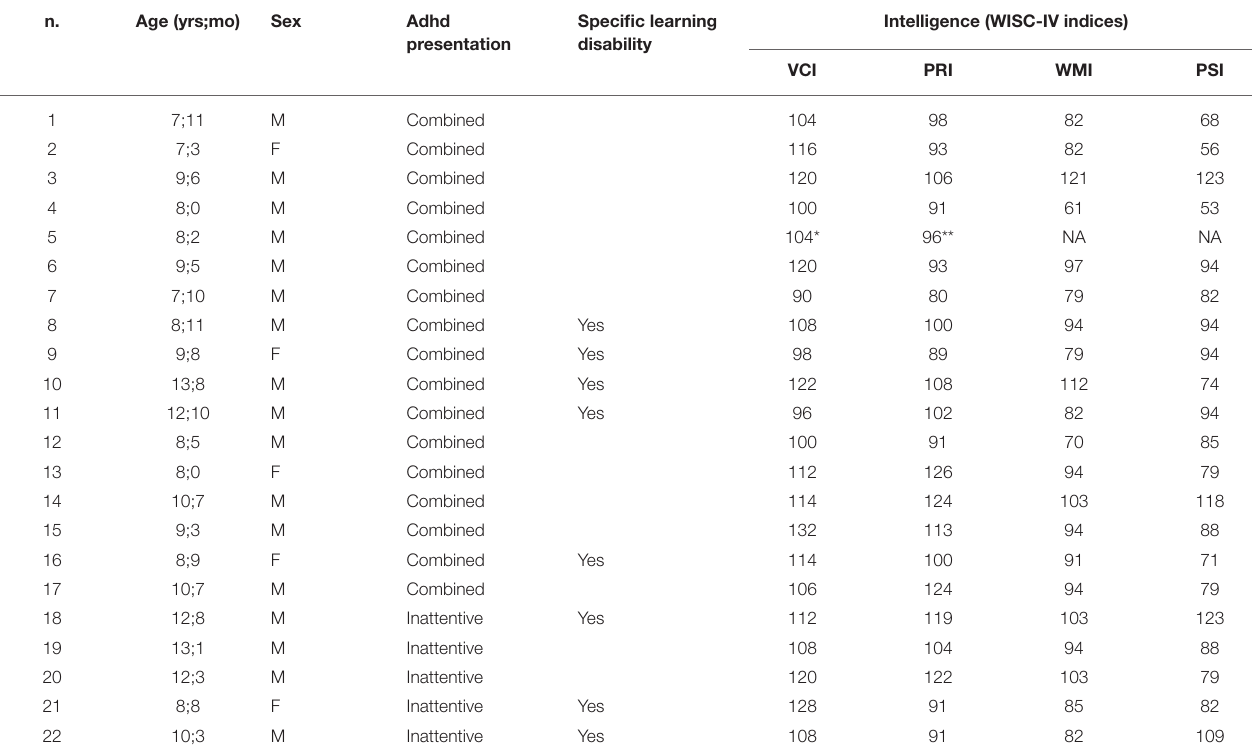
TABLE 1 | Demographic and clinical data of the ADHD sample.